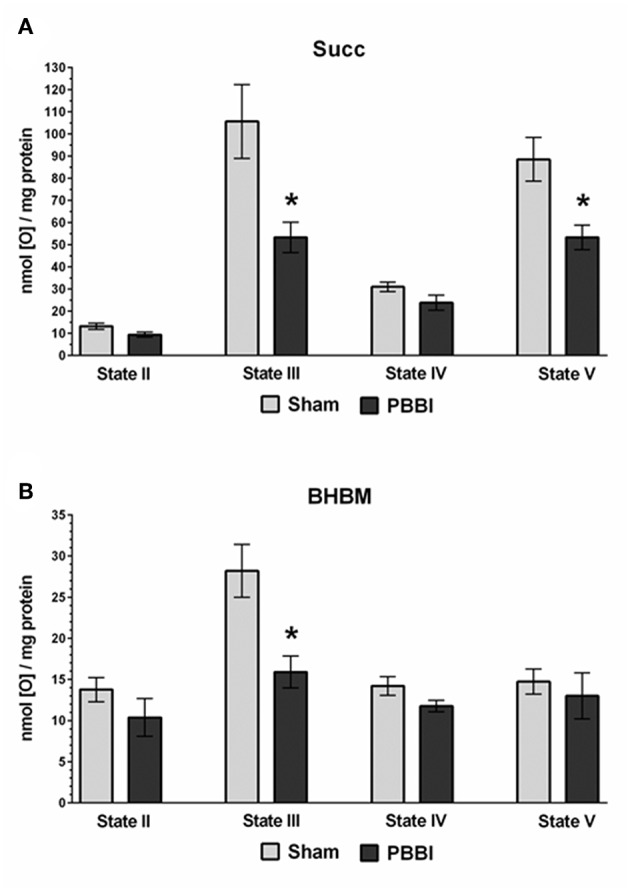
Decreased ATP synthesis in the presence of metabolic substrates Succ and BHBM following PBBI. (A,B) At 24 h post-PBBI or sham injury, mitochondrial respiration rates were measured using Clark-type oxygen electrode in the presence of metabolic substrates succinate (Succ) and β-hydroxybutyrate+malate (BHBM). PBBI reduced the Complex II driven ATP synthesis (State III) with Succ (50%, *p < 0.05) and BHBM (43%, *p < 0.05). No change in basal respiration (State II) and proton leaks (State IV) rates were observed. The FCCP induced uncoupling rates (State V) with Succ were significantly reduced in the PBBI group (40%, *p < 0.05). Bars represent group means ± SEM (n = 5 animals / group). *p < 0.05 compared to sham injured group (unpaired t-test).